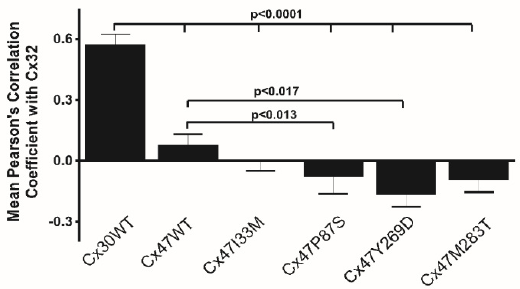
Figure 2. Graphic representation of results of experiments to determine colocalization of Cx32WT with Cx47WT and mutants. As shown, cells expressing Cx30WT and Cx32WT show significantly more correlation in the overlap of staining than do any of the other pairs of co ‐ expressed connexins. Cells expressing Cx32WT and Cx47WT showed essentially no correlation of staining for the two connexins and cells expressing Cx32WT with either Cx47I33M, Cx47P87S, or Cx47M283T showed only a slight and non ‐ significant negative correlation of staining. Cells expressing Cx47Y269D and Cx32WT did show a statistically significant negative correlation of staining. Figure and legend modified from Abrams et al. 2021 [63]. Used with permission of Wiley Periodicals LLC Copyright © 2023.